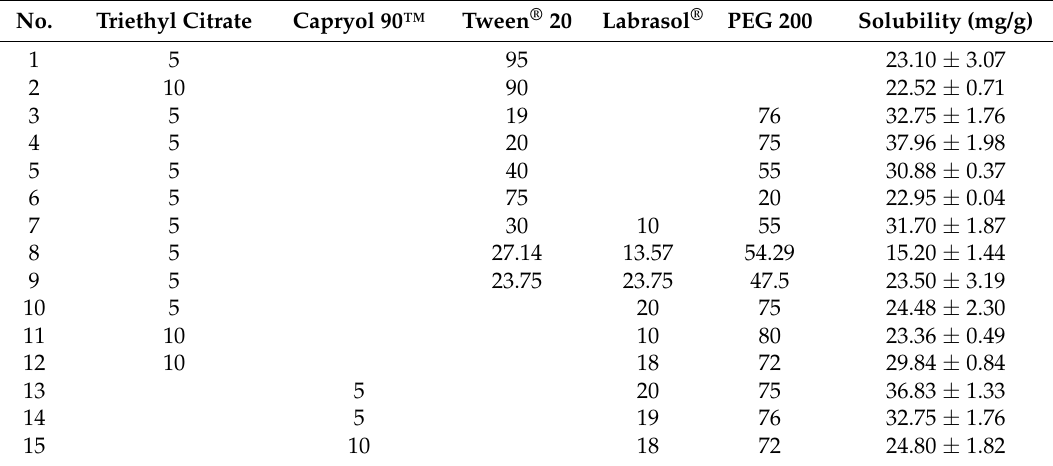
Table 3. Solubility of raloxifene hydrochloride in various SMEDDS formulations. All data are means ± SDs ( n =